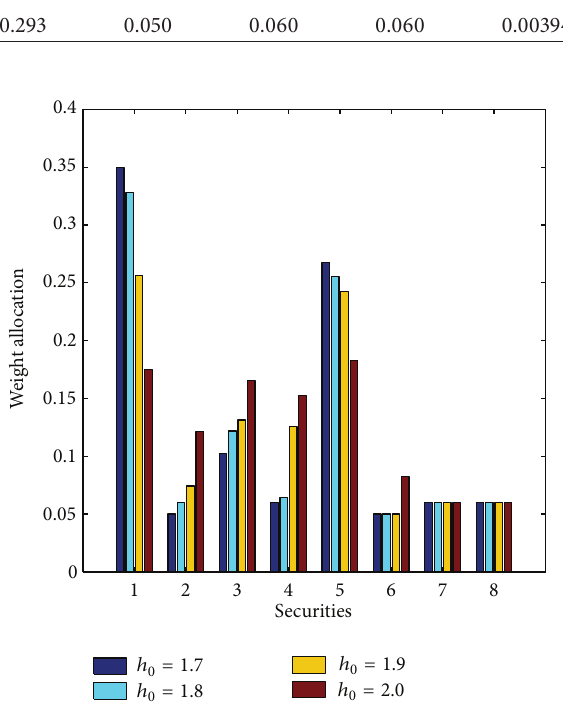
Figure 1: Comparison results under different diversification